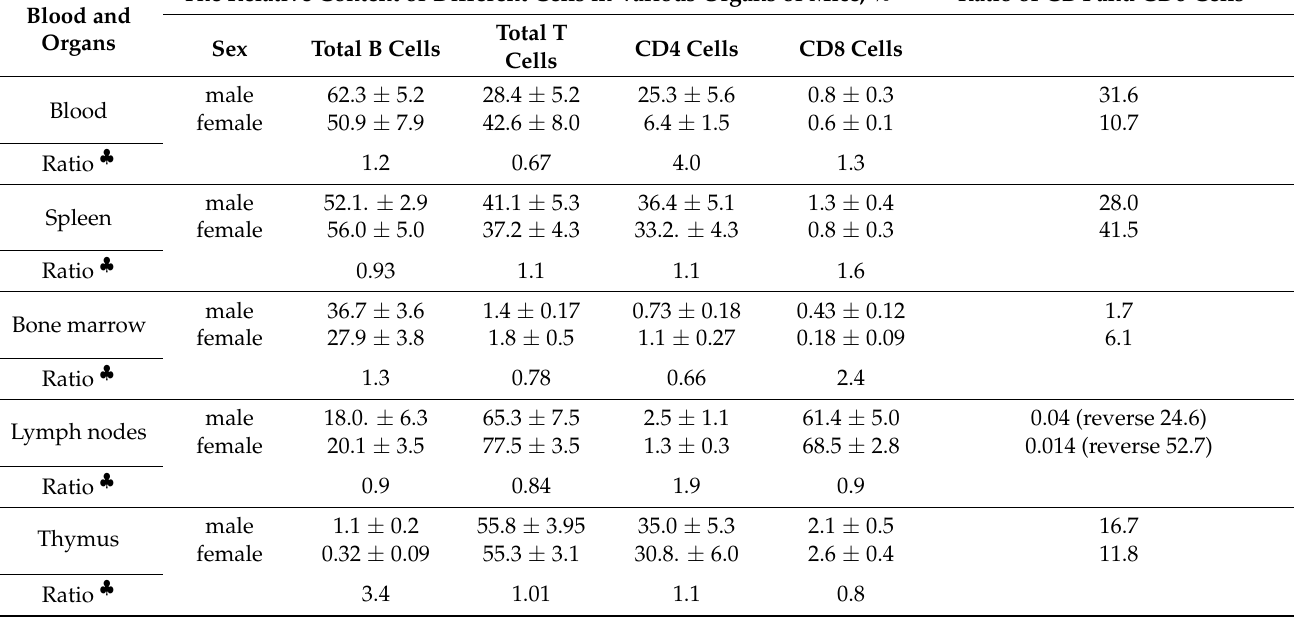
Table 1. The average percentage content of different cells in various organs of male and female mice over a period of three months